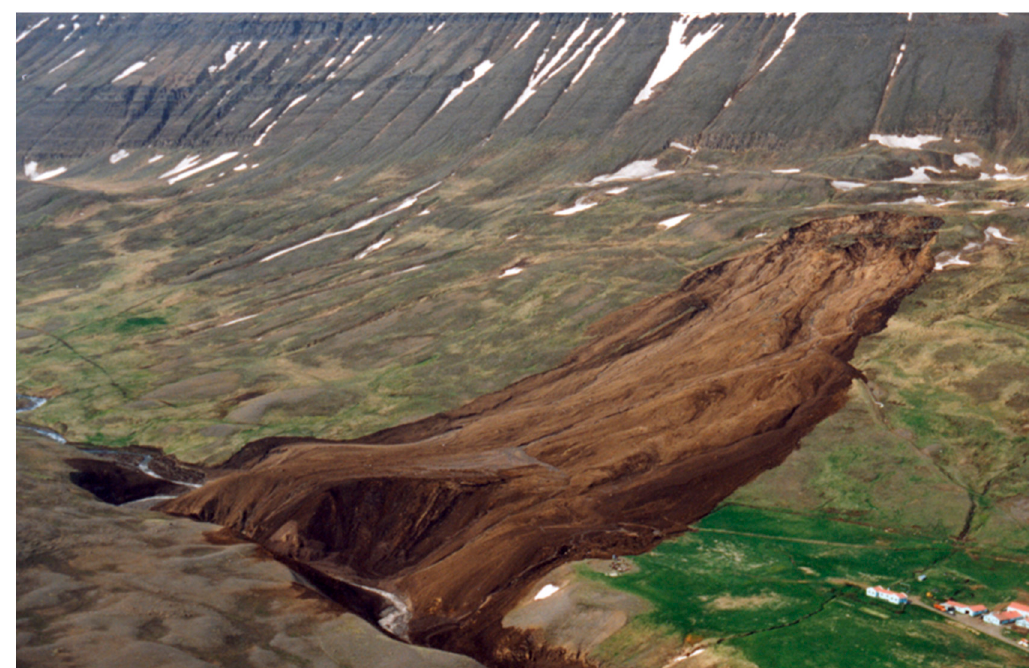
Figure 1. A photo of the Sölvadalur debris slide on 29 June 1995 (location map is on Figure 4). The slide was initiated at 580 m a.s.l. and fell into the Þormóðsstaðará canyon at an elevation of 340 m. The width of the slide at the rim of the canyon is about 4–500 m. Note the farm Þormóðsstaðir to the lower right corner of the photo (Photo by Björn Gíslason, 1995).